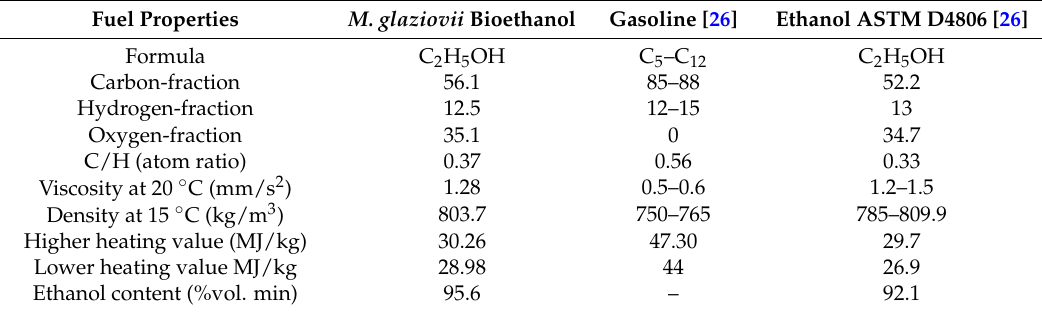
Table 6. Comparison of the properties of M. glaziovii bioethanol, gasoline and